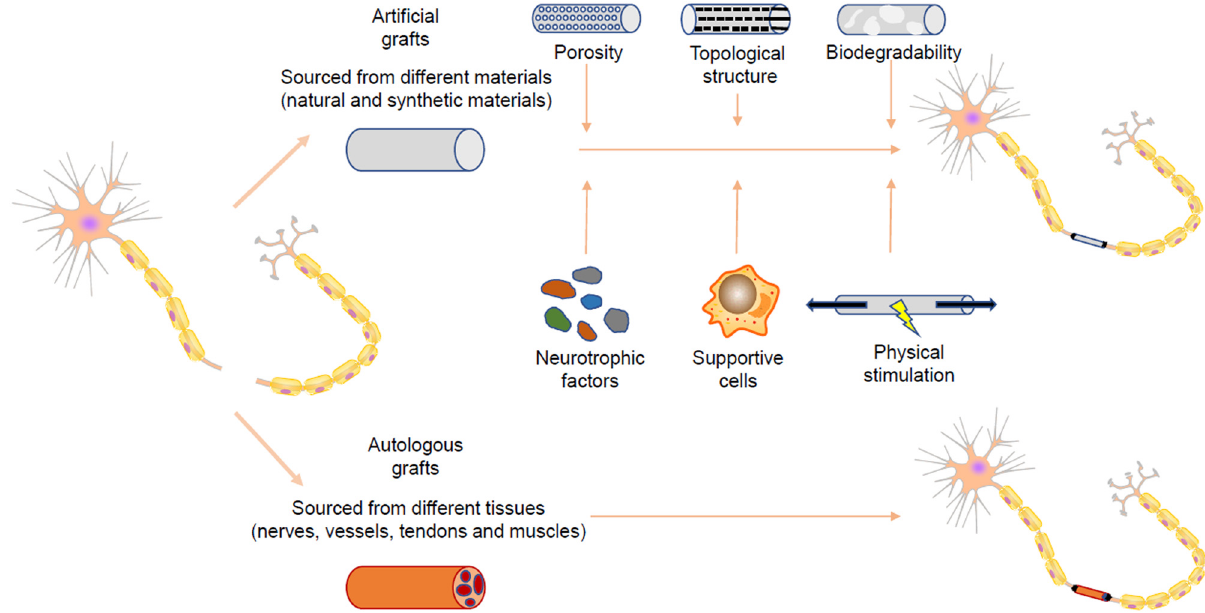
Figure 2: Schematic illustration of peripheral nerve repair strategies via tissue - engineered conduit